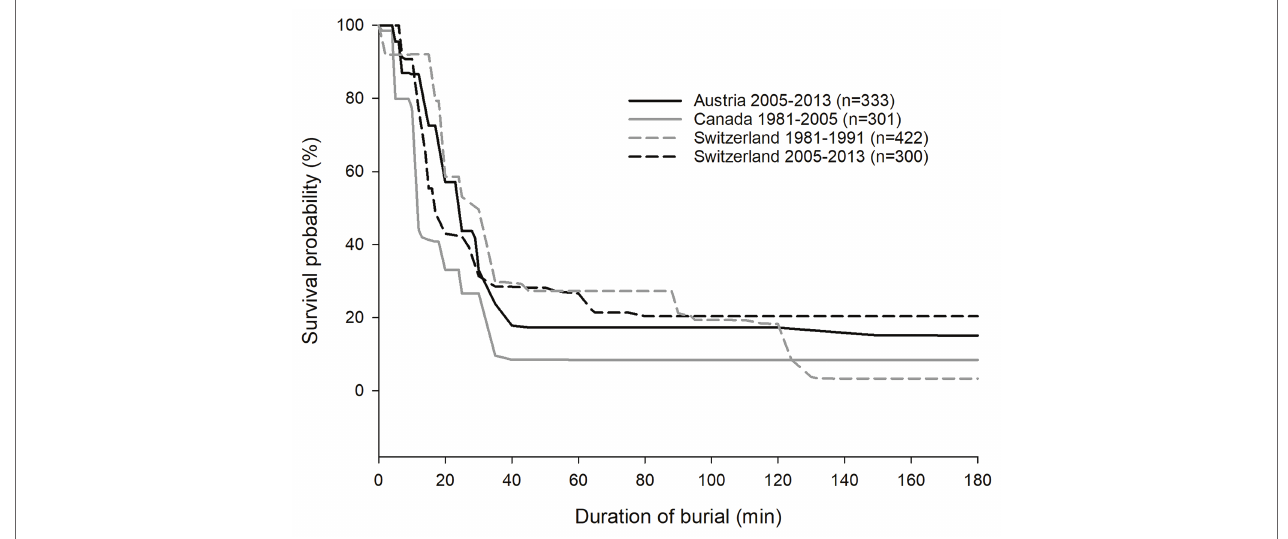
FIGURE 4 | Survival curves for Austria (solid black line: 2005–2013), Canada (solid gray line: 1981–2005), and Switzerland (dashed gray line: 1981–1991; black dashed line: 2005–2013) for completely buried victims (modified from Falk et al., 1994; Haegeli et al. 2011; Procter et al., 2016).